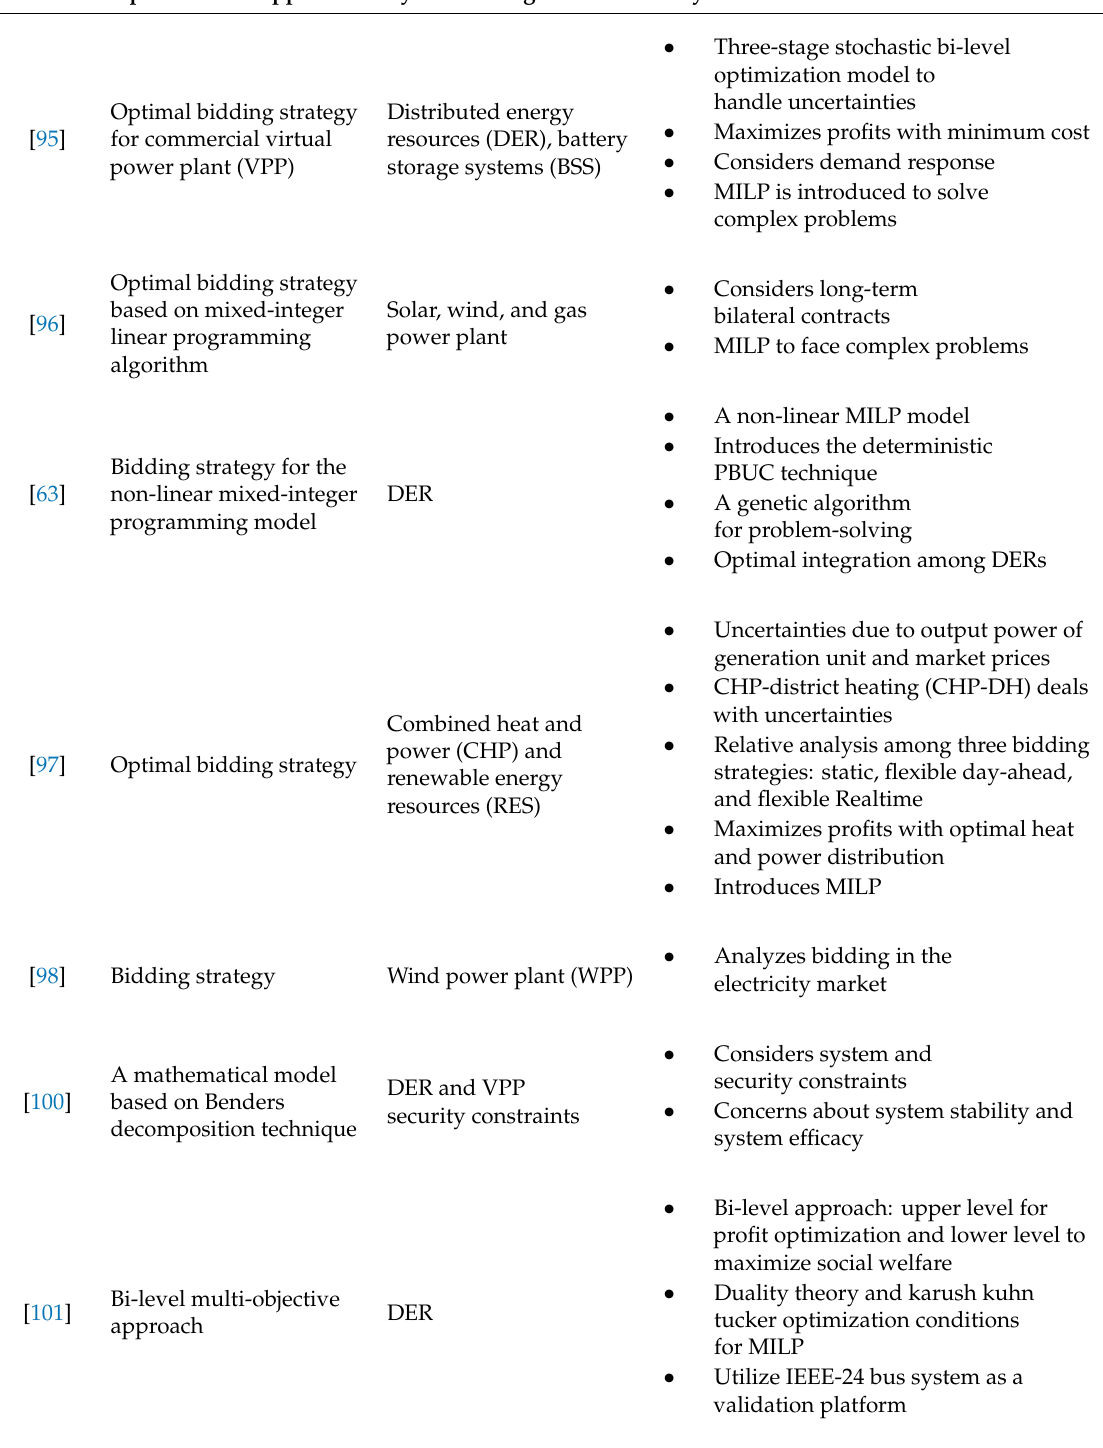
Table 5. A comparative analysis among di ff erent optimal bidding strategies for virtual power plant.